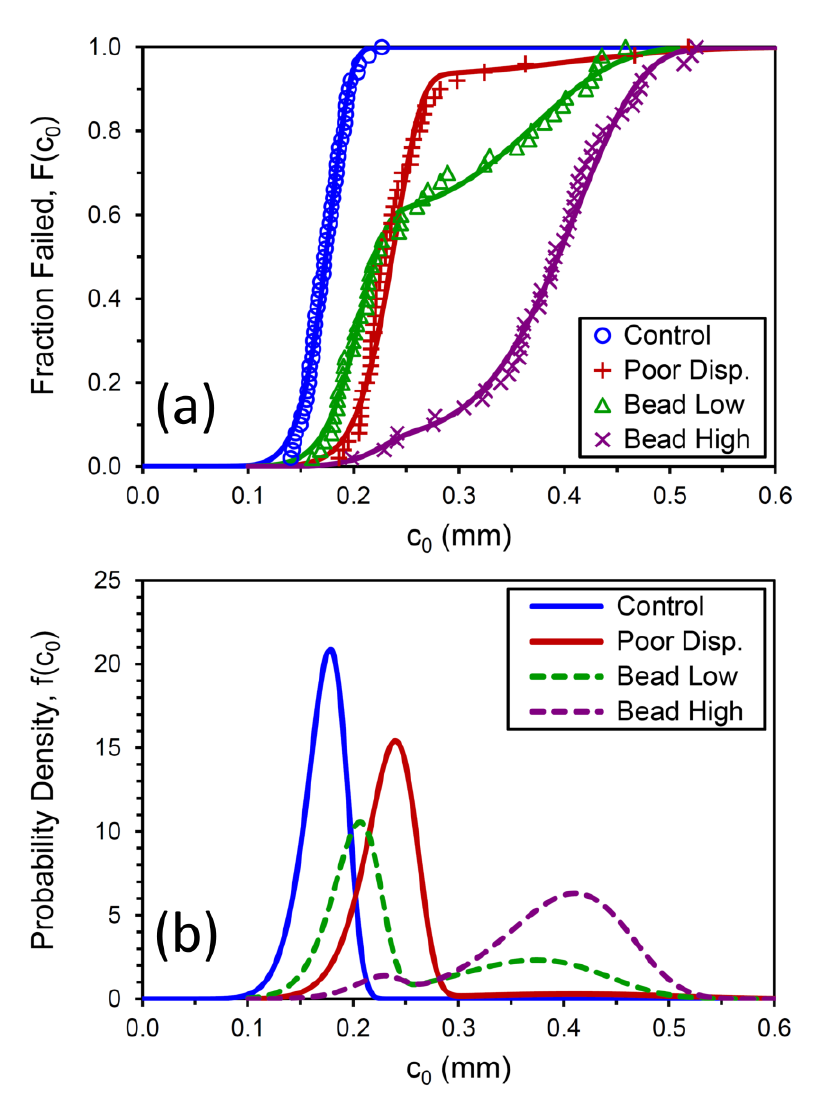
Figure 7. Measured crack precursor size ( c 0 ) distributions for the four compounds (symbols) and Weibull cumulative distribution function fits (lines) ( a ); associated Weibull probability density functions ( b ).